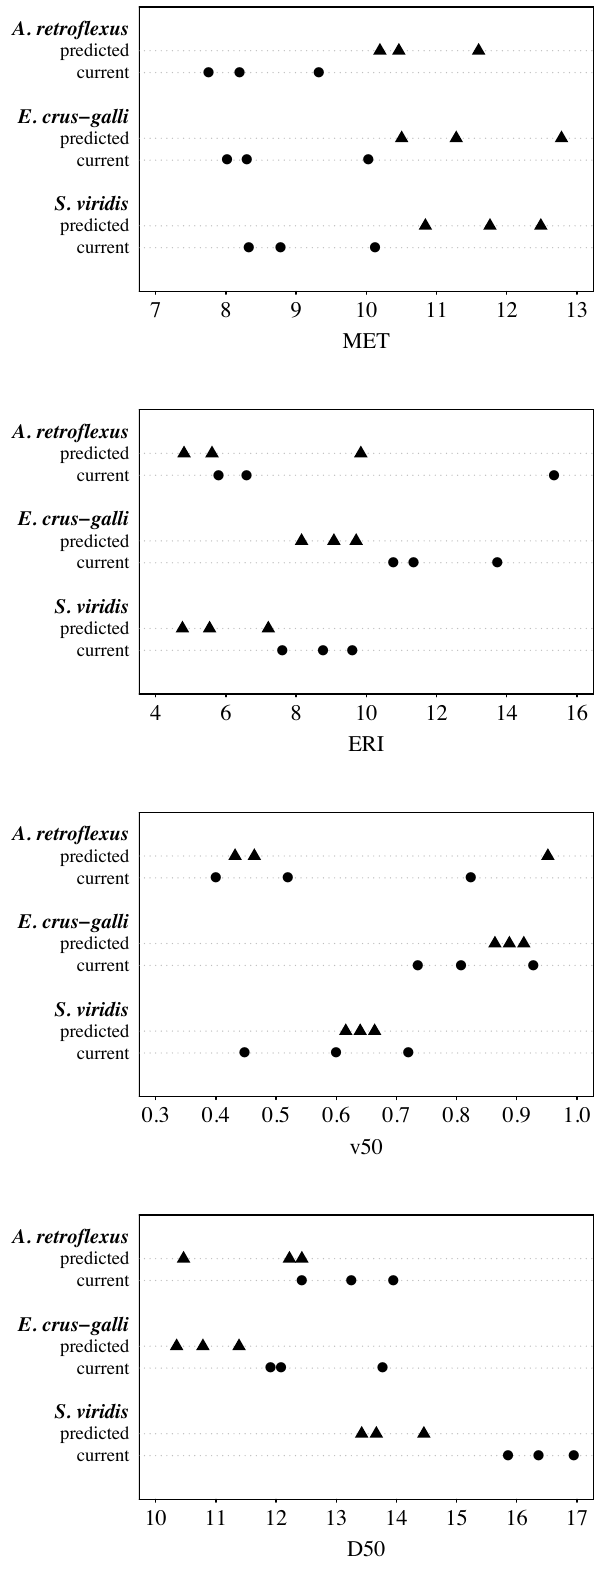
Fig. 3: Parameters characterising emergence : MET = Mean Emergence Time, ERI = Emergence Rate Index, v 50 = emergence rate at time of mid emergence, D 50 = the calculated day on which 50% the total emerged seeds have emerged; n = 3, triangles show values under predicted future conditions, circles show values recorded under cur- rent